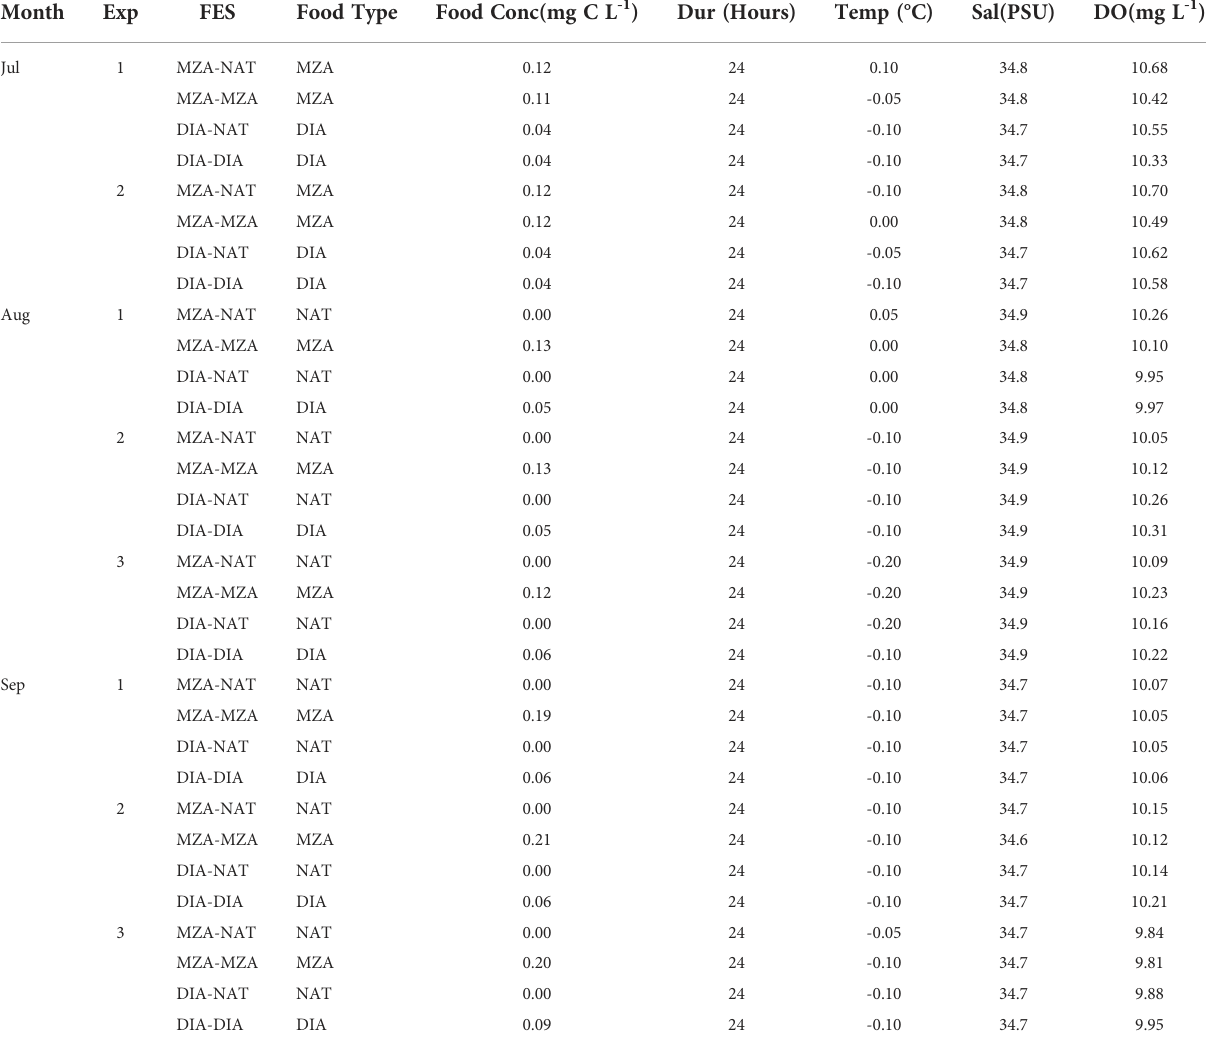
TABLE 2 Summary of functional response experiments conducted in July, August, and September.